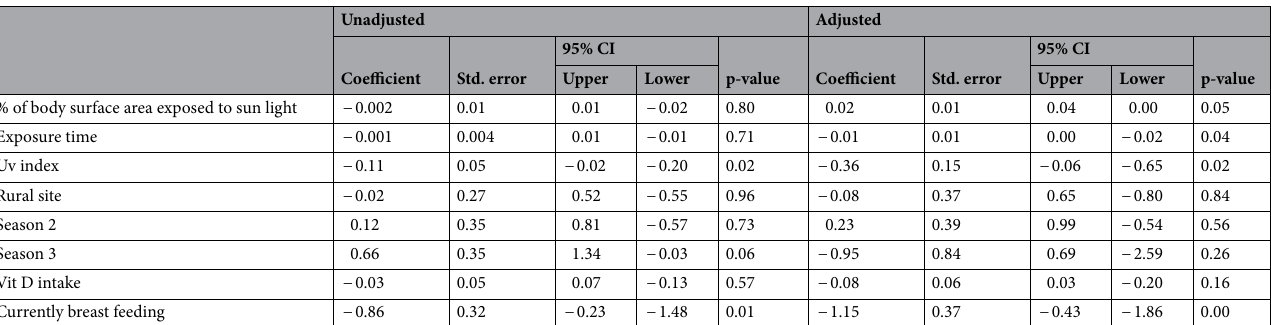
Table 3. Factors associated with vitamin D deficiency among 12–24-month-old children living in an urban and rural Bangladesh (Ref.